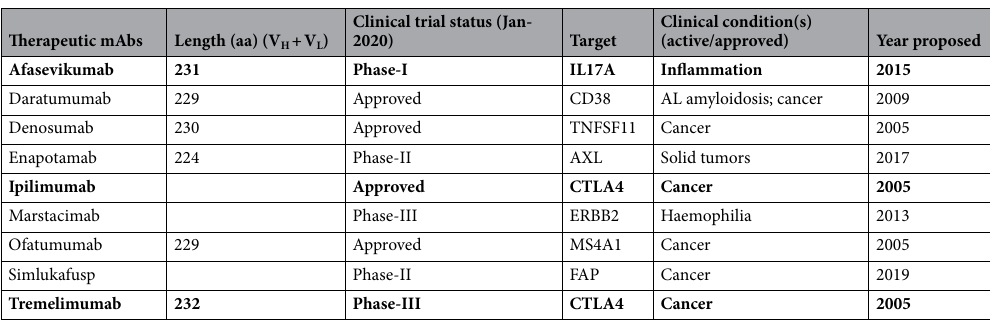
Table 1. List of shortlisted therapeutic antibodies and their specifics. Highlighted antibodies were chosen as promising candidates. Further comprehensive analysis was carried out on these candidate antibodies to gauge their potential use in COVID-19